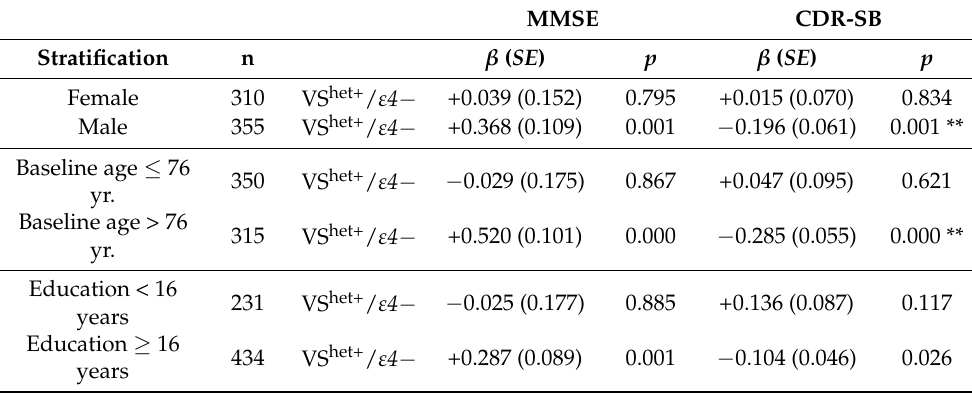
Table 5. Longitudinal LMM analyses investigating the effect of KL- VS het+ status for annualized rates of cognitive decline in ε 4 non-carriers stratified by sex, median baseline age, and median education level. For all comparisons, the reference group was KL- VS het − / ε 4 −